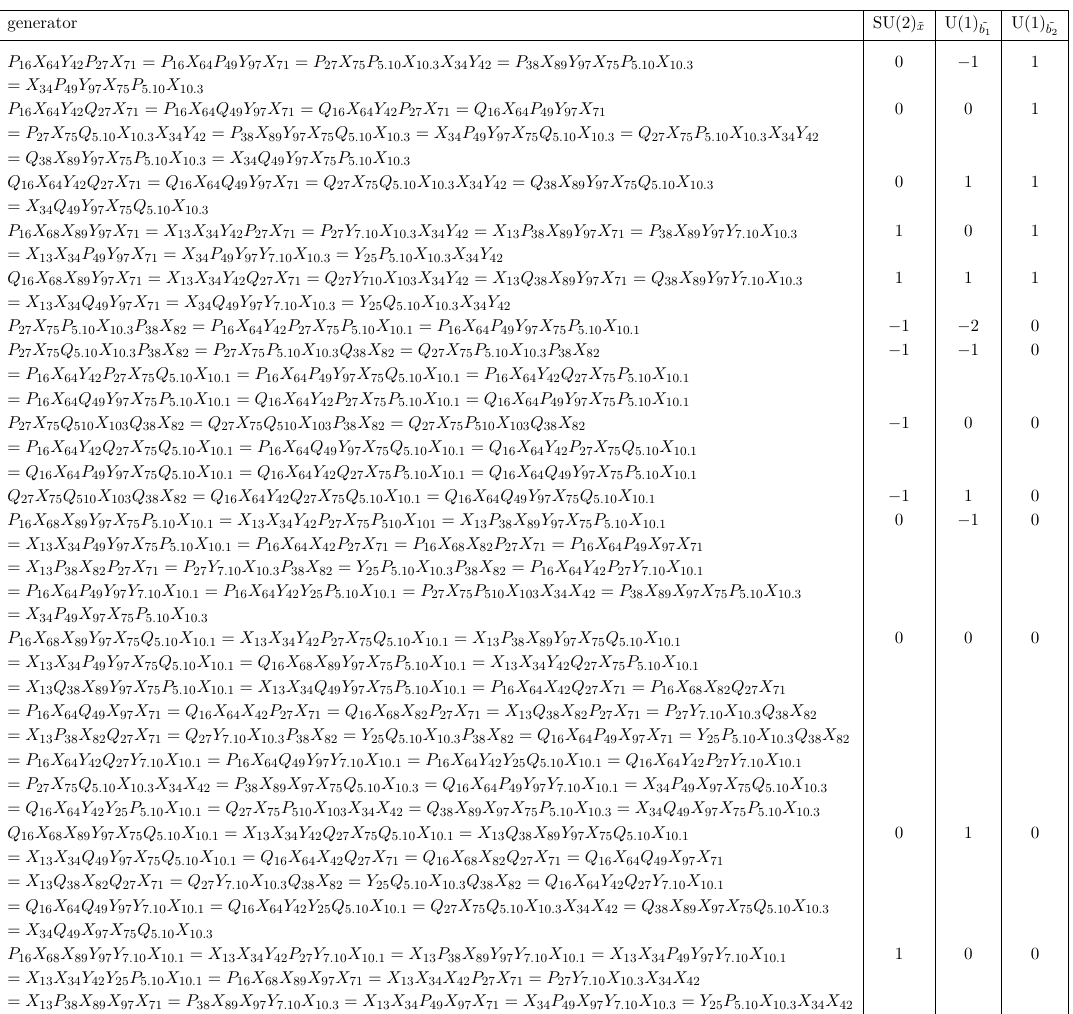
Table 53 . The generators in terms of bifundamental chiral fields for Model 13 (Part 1)